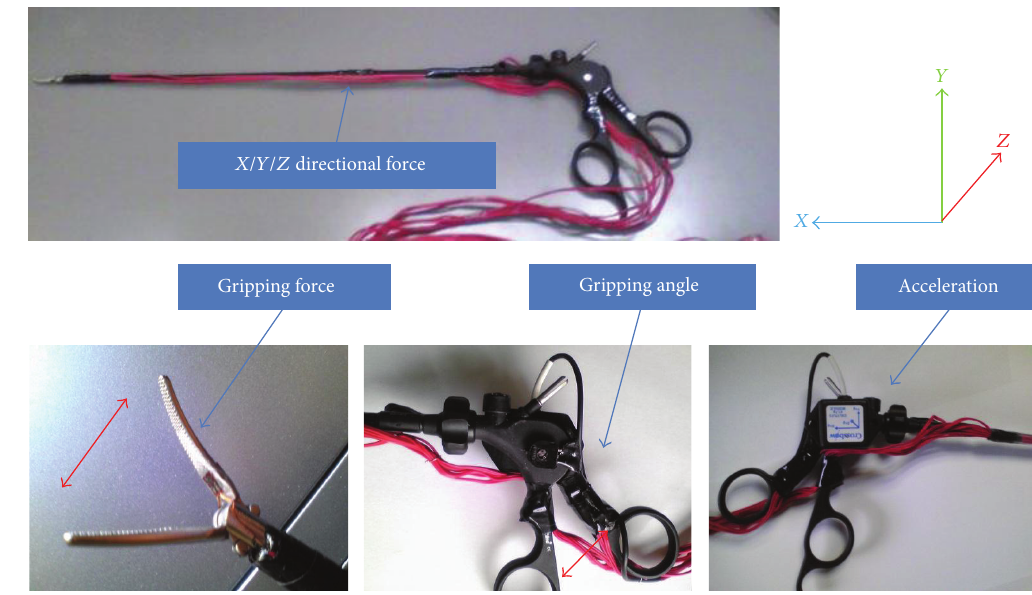
Figure 2: The forceps we